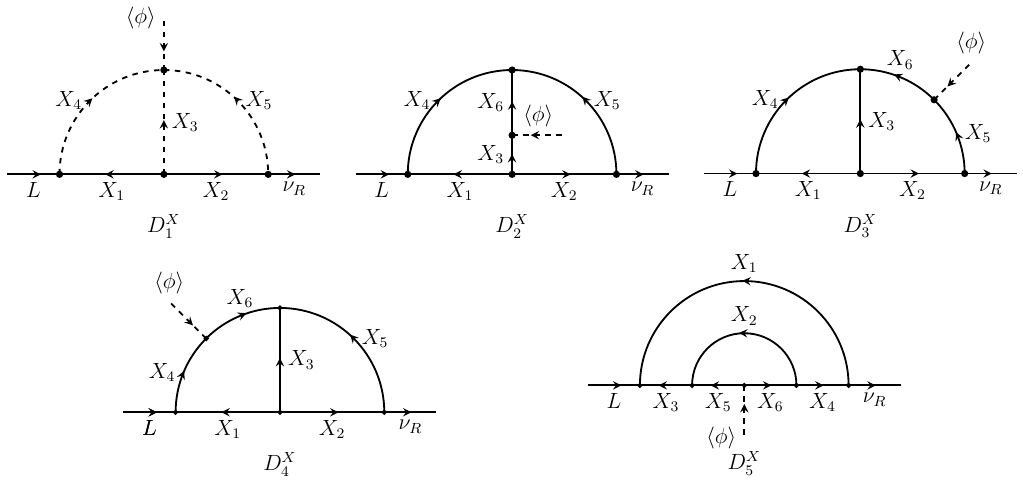
Figure 8 . Auxiliary diagrams with a symbolic assignment of the internal (cid:12)elds at topology level. The external lines are assigned to L , (cid:30) or (cid:23) R , while the internal (cid:12)elds X i if represented by solid lines, can be either scalar or fermions. The arrows indicate the (cid:13)owing of the quantum numbers. In (cid:12)gure 8, the internal (cid:12)elds X depicted as solid lines, can be either scalars or i fermions. The only exception is in the D X diagram where, due to the quartic coupling, 1 X , X and X can only be scalars and as such are drawn with dashed lines. This 3 4 5